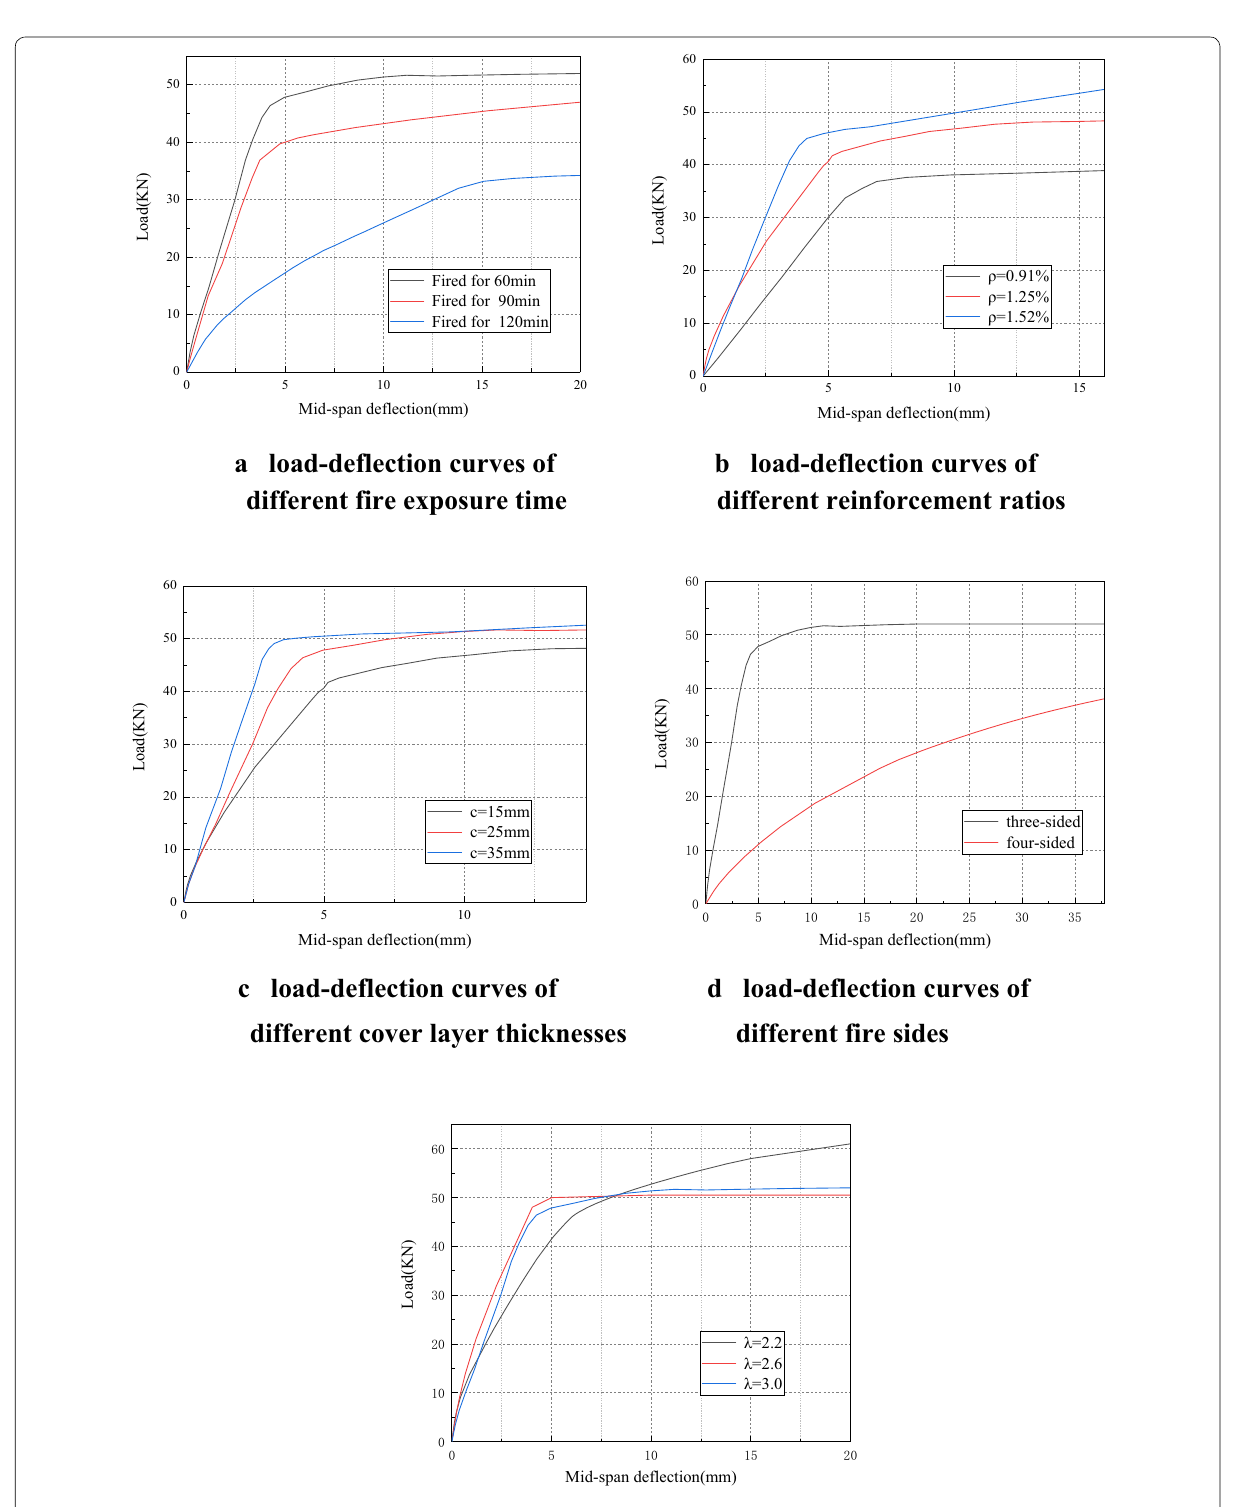
Fig. 18 Variation of load–flexural capacity of beams under different